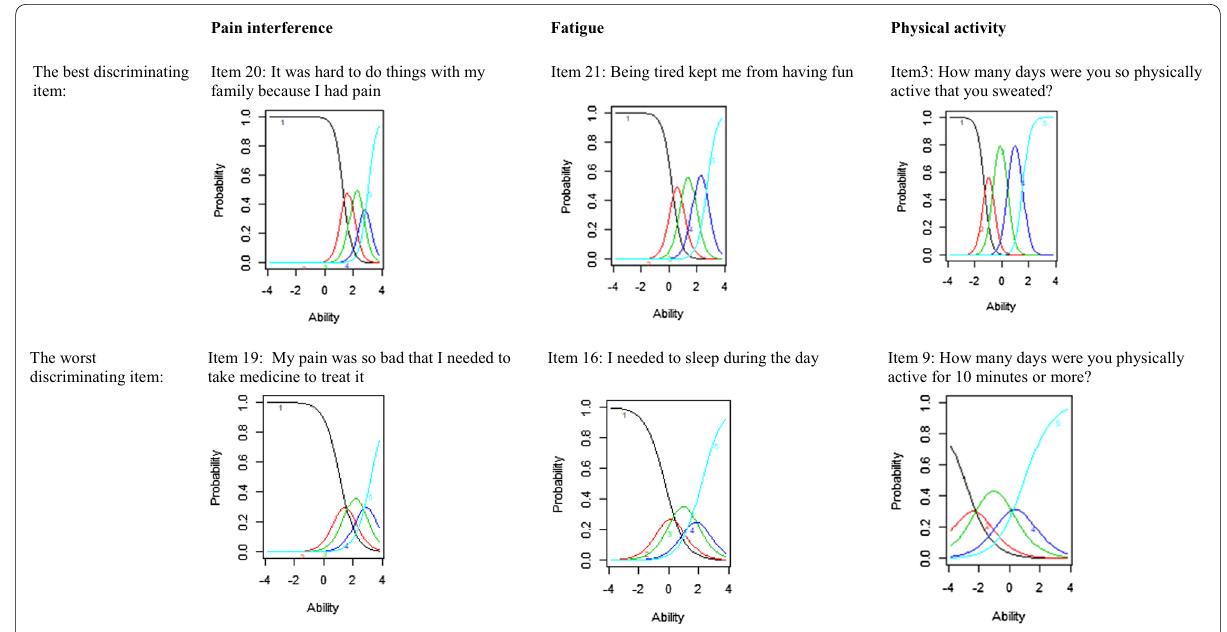
Fig. 2 The best and worst discriminating items in the Swedish translated item